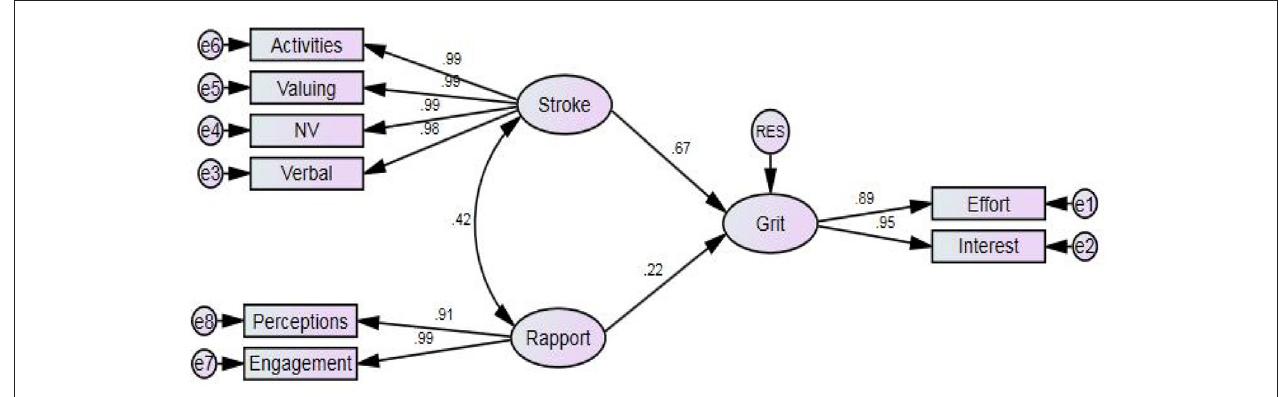
FIGURE 2 | The measurement model.